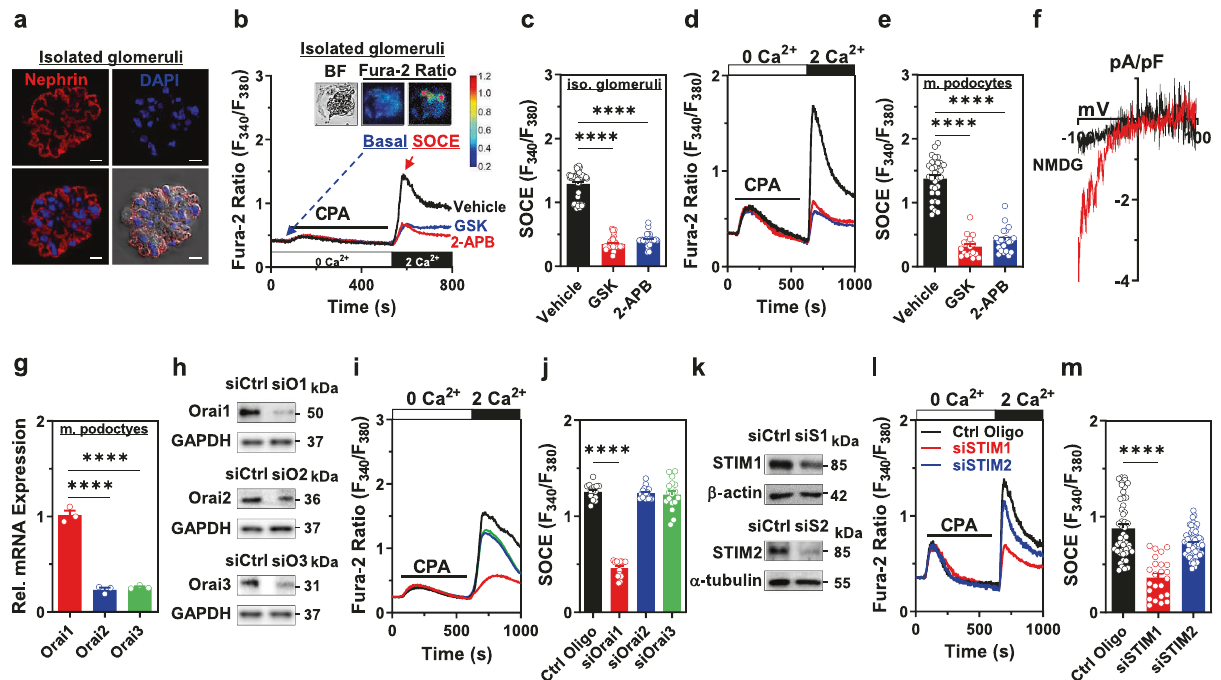
Fig. 1 Orai1/STIM1 is a primary molecular component of functional store-operated Ca 2 + entry (SOCE) in podocytes. a Immuno fl uorescence images of nephrin (red) and DAPI (blue) stains in isolated mouse glomeruli and differential interference contrast (DIC) results combined with those of nephrin and DAPI staining. Scale bar = 10 μ m. b Effect of Orai inhibitors on functional SOCE in isolated mouse glomeruli. Representative images of bright- fi eld (BF) and fura-2 fl uorescence microscopy of podocytes in the basal and SOCE states, carried out in situ on acutely isolated mouse glomeruli, in the same manner as described in the previous reports 9 . Pre-treatment with Orai inhibitors, GSK (GSK-7975A; 3 μ M) or 2-APB (100 μ M), was performed 1 h before